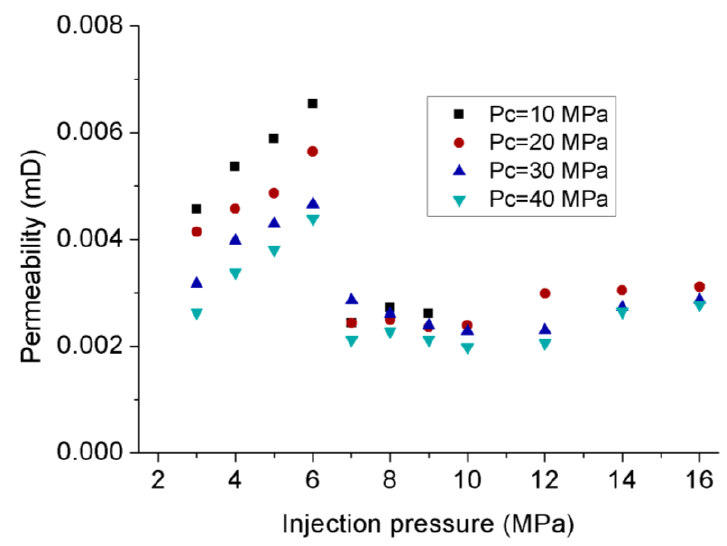
Figure 13. Relationship between apparent permeability of siltstone under different injection pressures (proposed method).